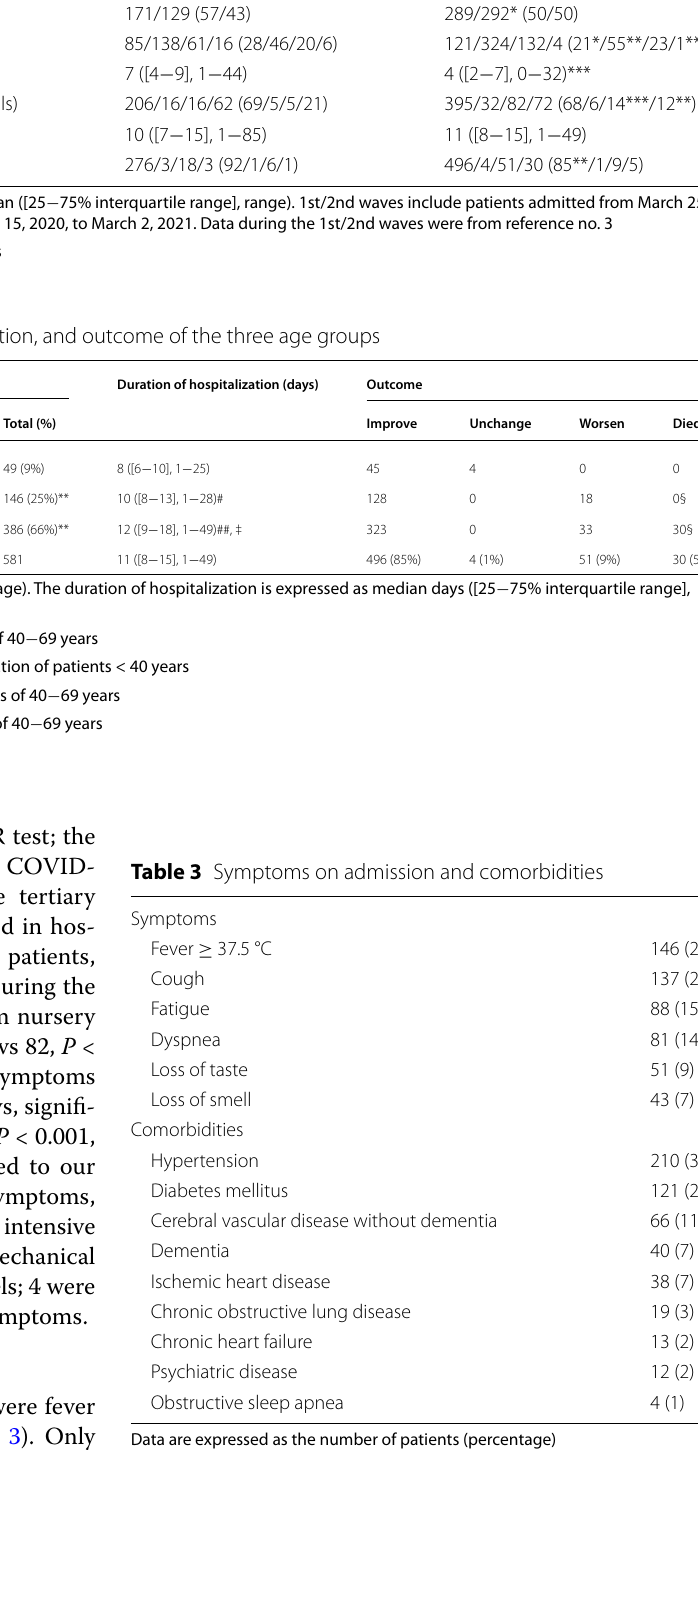
Table 1 Characteristics of patients with COVID-19 in the 1st/2nd and the 3rd waves